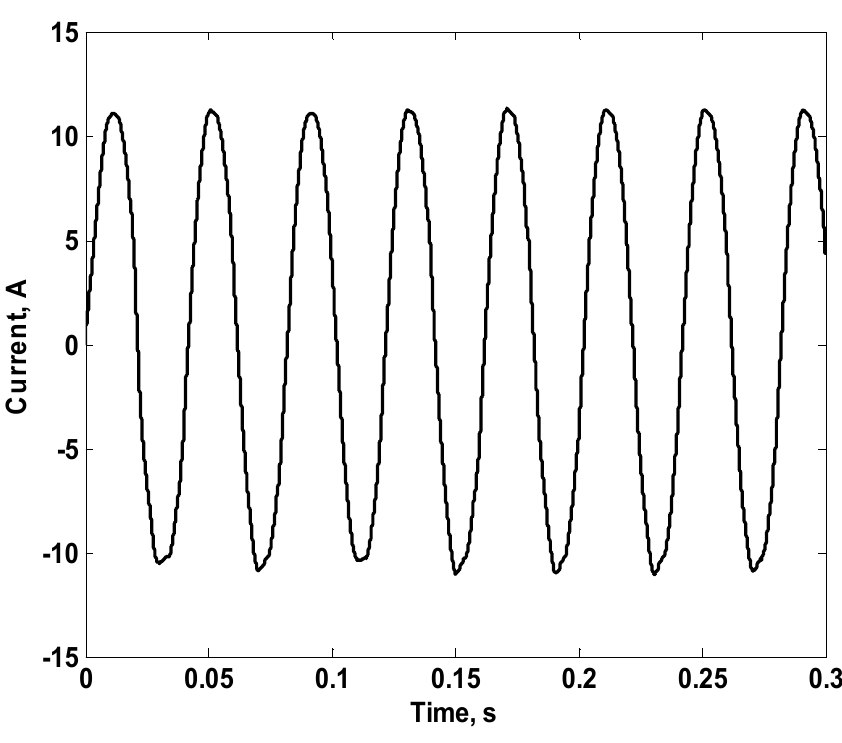
Figure 14. A 25 Hz Load Current.